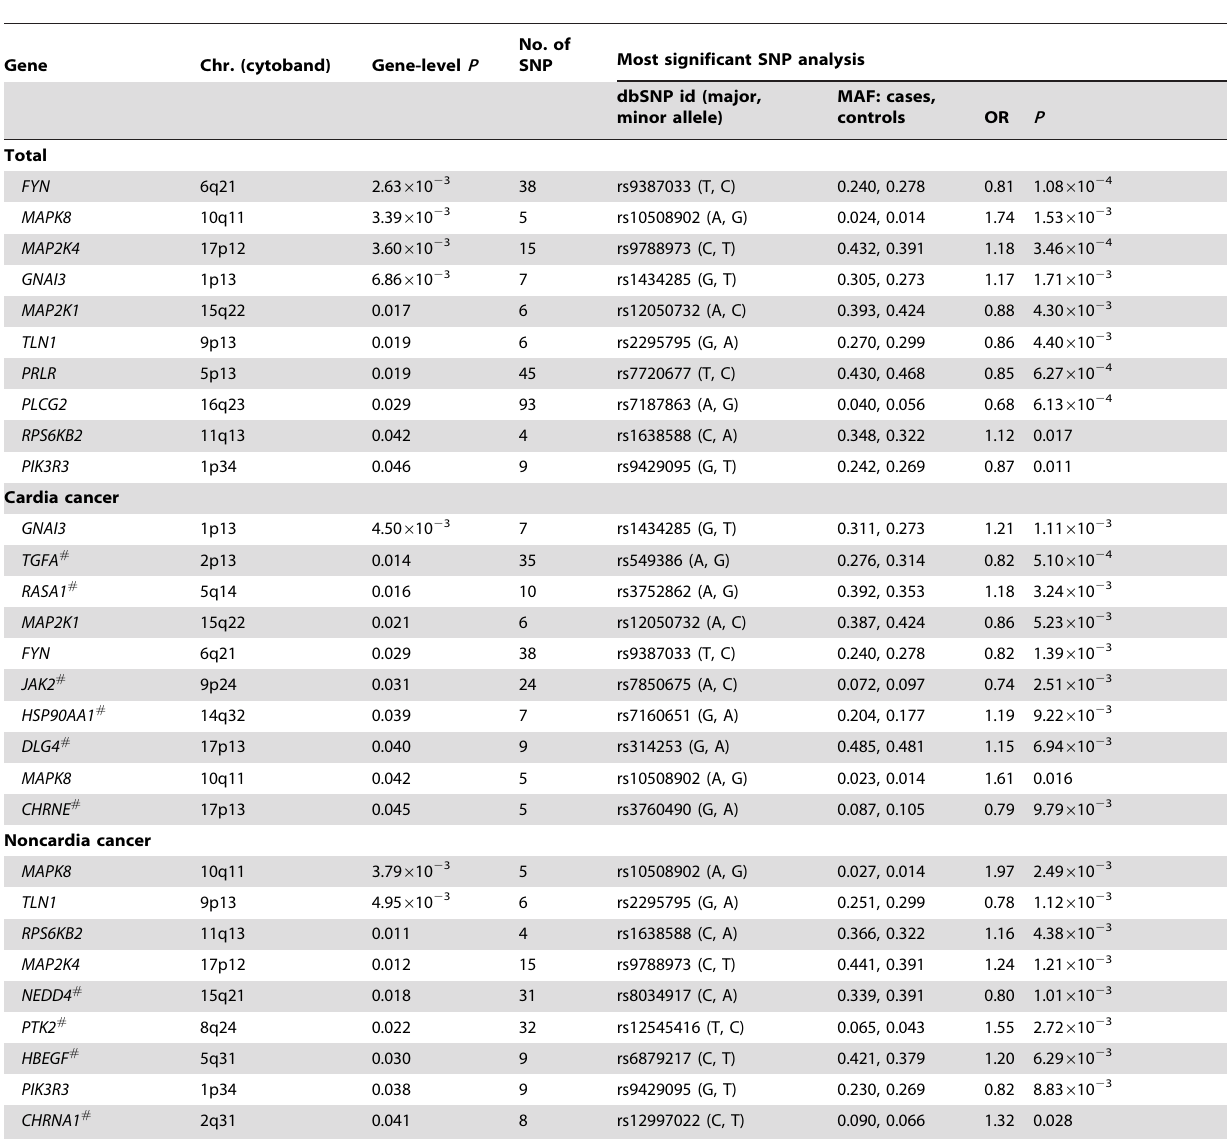
Table 2. Epidermal growth factor receptor pathway genes significantly associated with risk of gastric adenocarcinoma overall and by anatomic sites *